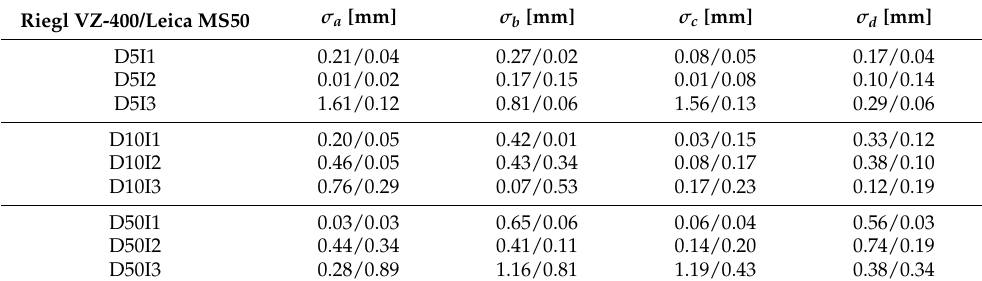
Table 5. Precision of the computed parameters: shift